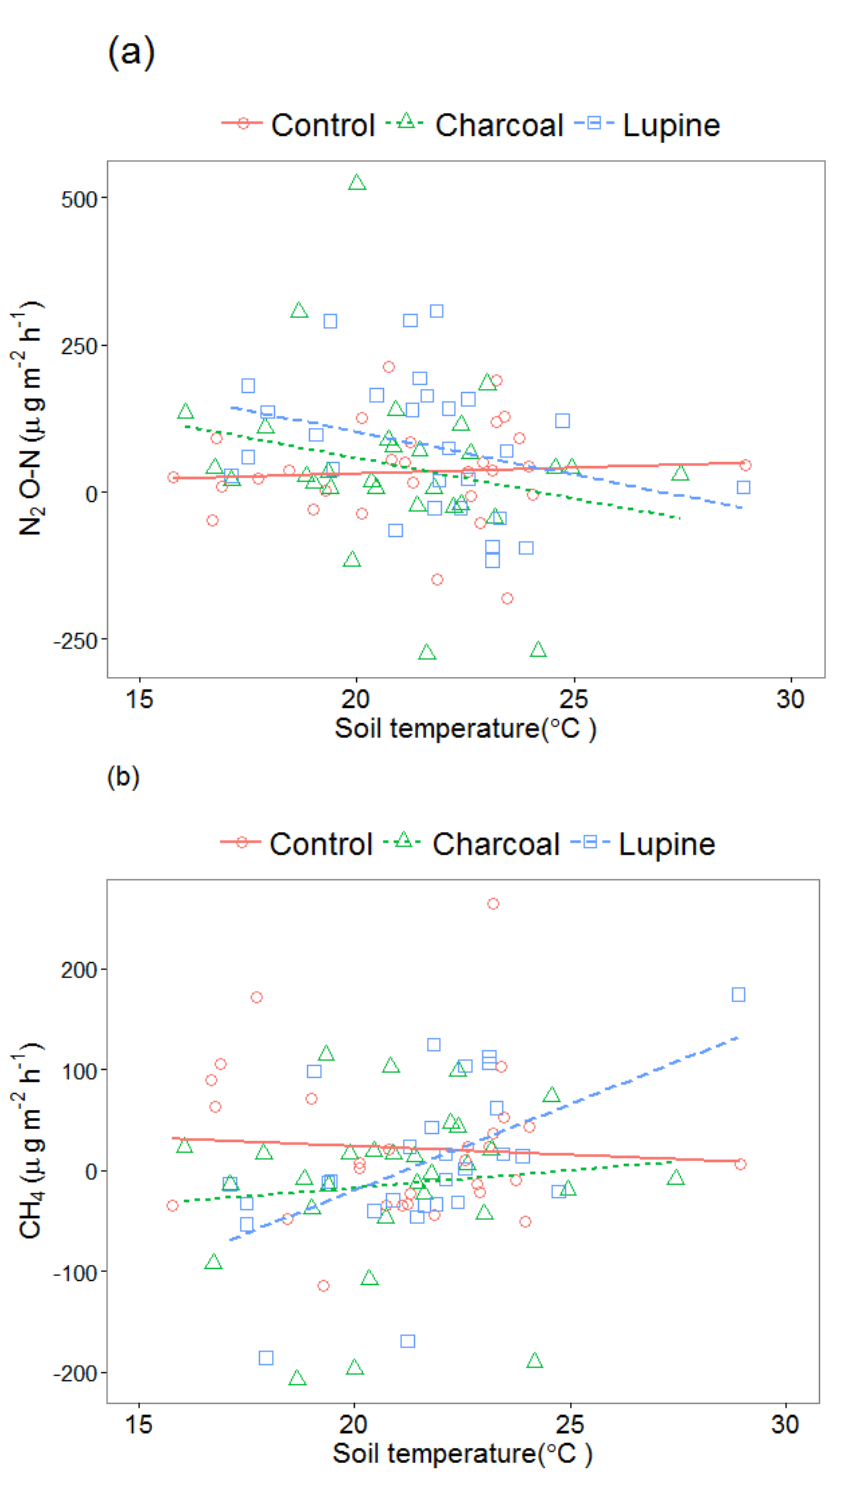
Figure A1. Correlation between soil temperature (at 5 cm depth) and nitrous emission with correlations values of 0.01, − 0.24, and − 0.30 for Control, Charcoal, and Lupine treatments, respectively ( a ) and methane − 0.05, 0.11, and 0.53 for Control, Charcoal, and Lupine treatments, respectively ( b ) based on combined data from all campaigns.